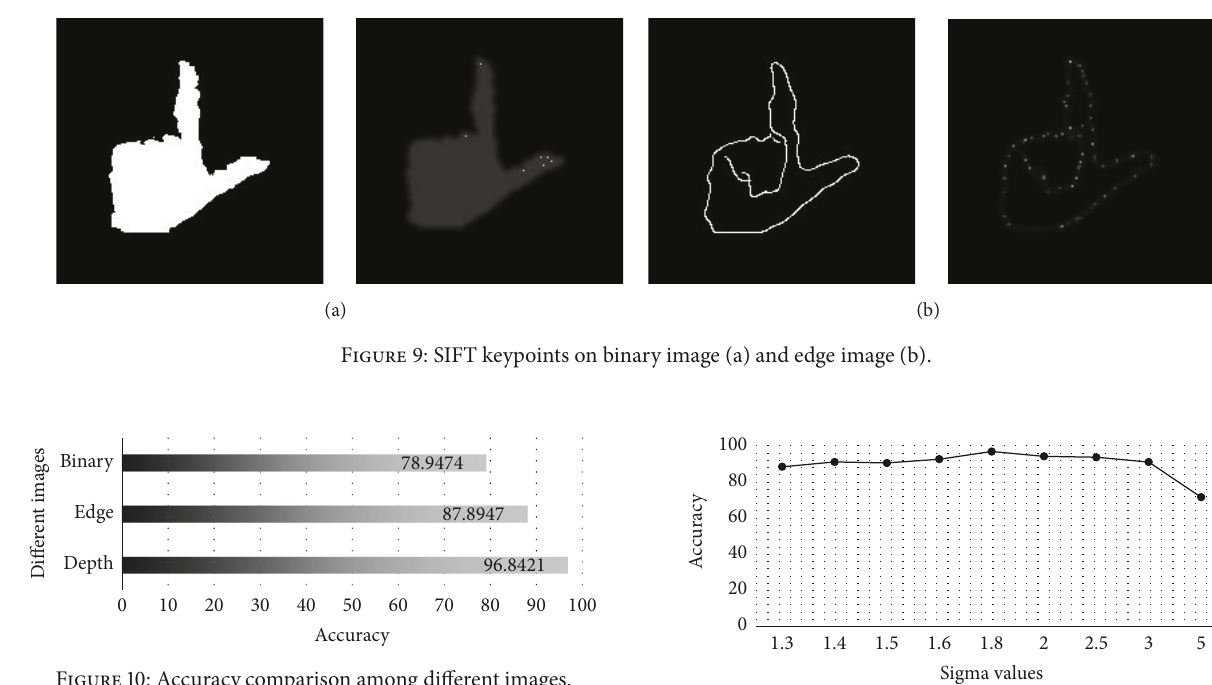
Figure 11: Accuracy at different sigma values.